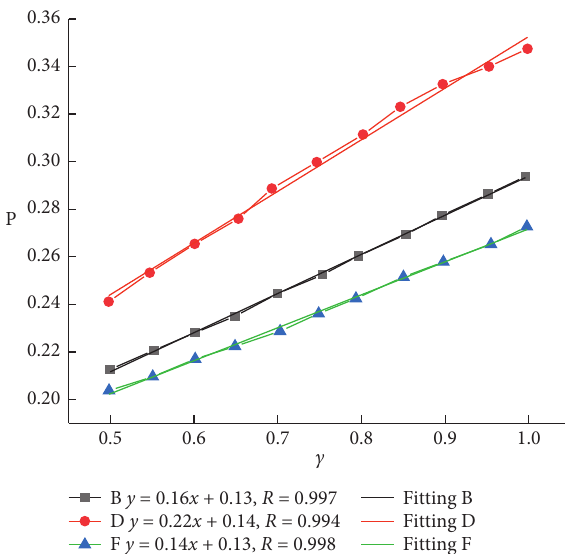
Figure 3: Relationship between the grey correlation degree and risk.